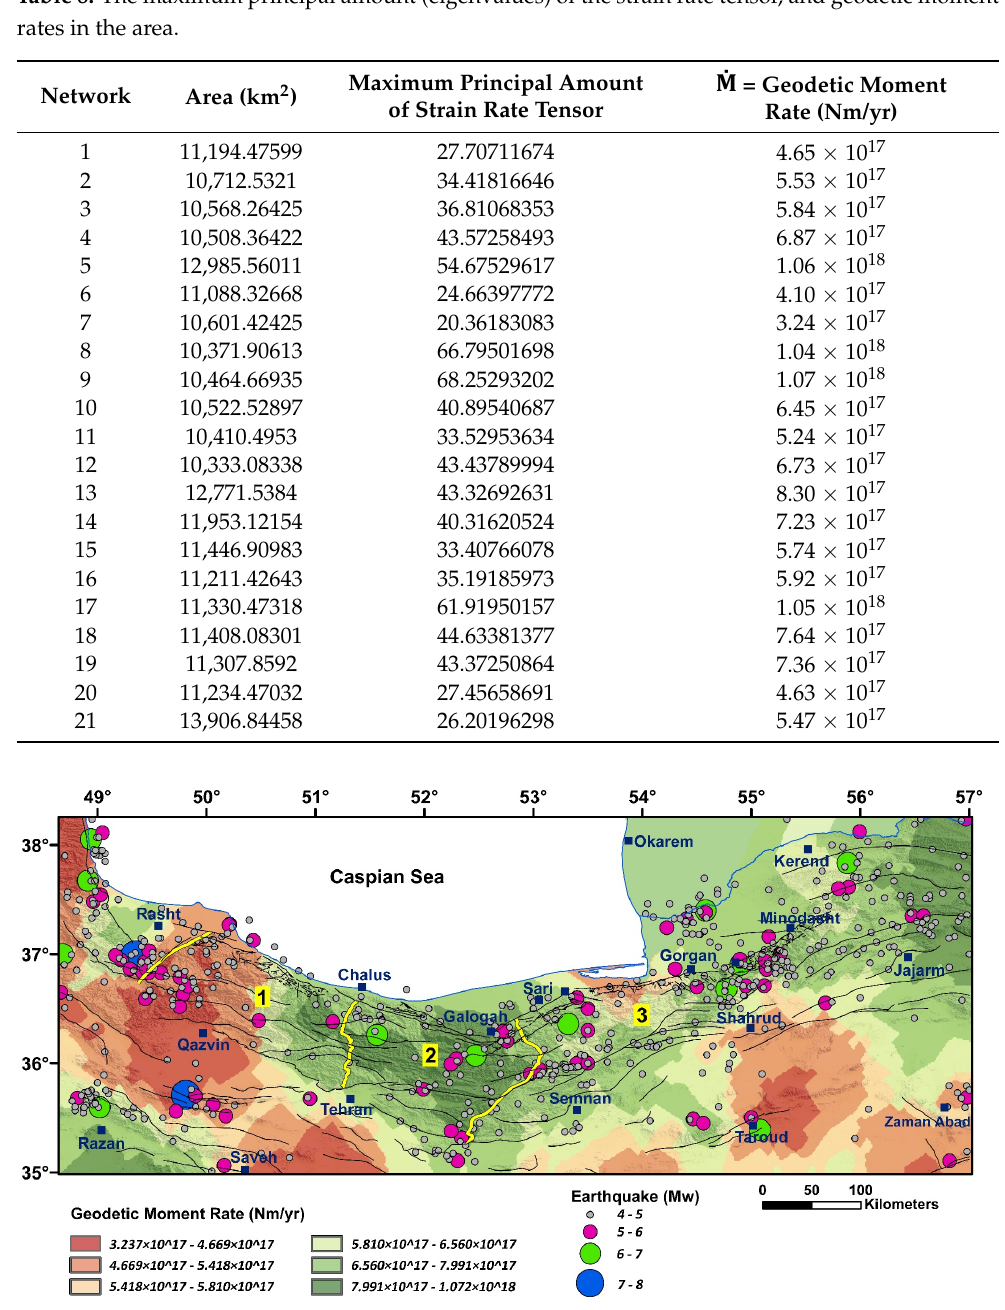
Figure 8. Zoning map of GMR with the distribution of the earthquakes (1900–2020). Numbers 1, 2, and 3 are location of the West Alborz, Central Alborz, and East Alborz, respectively which are separated by yellow lines.